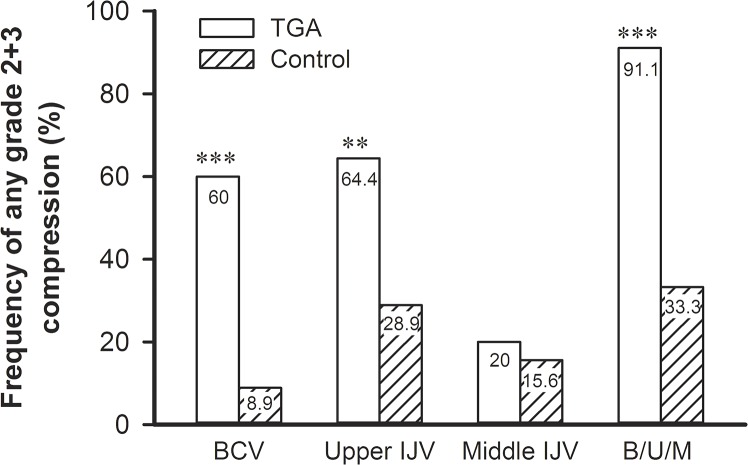
Differences between TGA (transient global amnesia) patients and controls in the frequencies of any significant venous compression of the venous outflow route on an individual basis.** P<0.01, *** P<0.001. BCV left brachiocephalic vein compression, IJV internal jugular vein, Upper IJV Upper IJV compression at either side, Middle IJV Middle IJV compression at either side, B/U/Mat least one site of venous compression/stenosis at left BCV or either side of Upper IJV or Middle IJV.